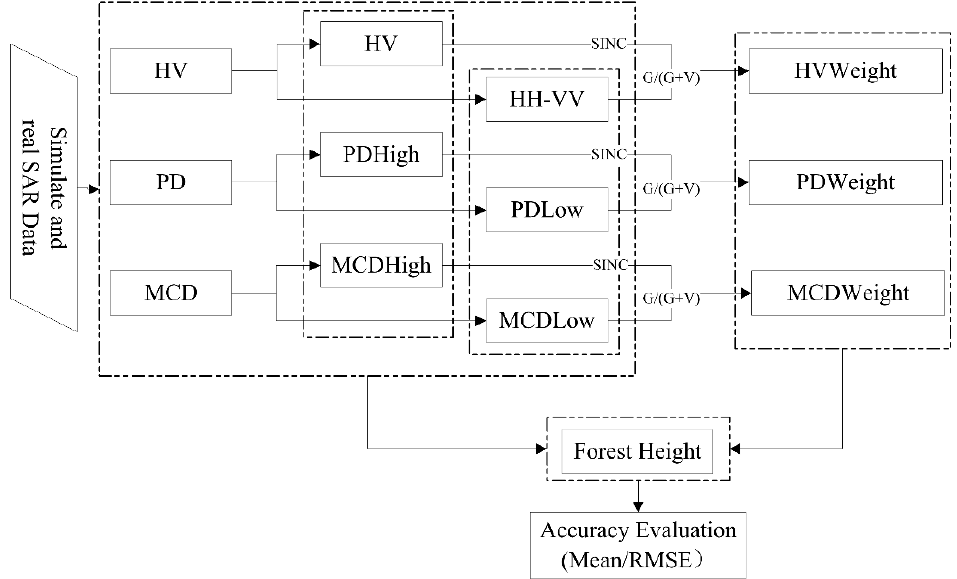
Figure 3. Forest Height Inversion Technology Roadmap.